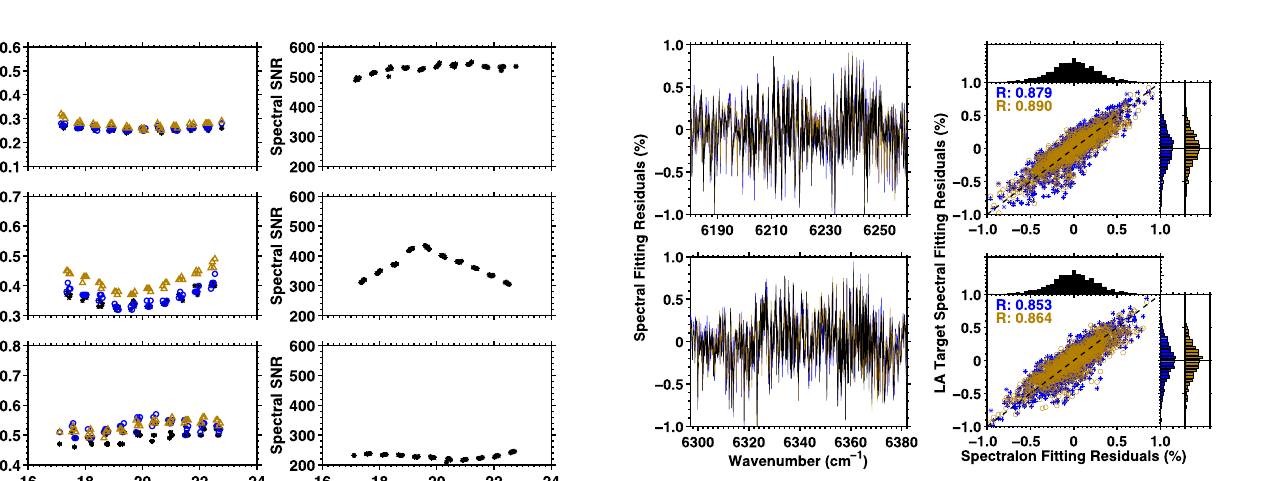
Figure 6 . The spectral fitting residuals (left panels) and their correlation, Pearson correlation coefficients (R), and histograms (right panels) with MW6220 (top panels) and MW6339 (bottom panels) for CO 2 slant column density measurements. In left panels, black curve is for Spectralon viewing geometry; blue curve is for west Pasadena; gold curve is for Arcadia Race Track. In right panels, blue stars are the correlation between Spectralon and west Pasadena; gold circles are the correlation between Spectralon and Arcadia Race Track; the black dash lines indicate the one to one correlation. The spectral fitting residuals were generated using the co-addition of residuals of 41 spectral fittings of Spectralon target, 41 spectral fittings of west Pasadena target, and 40 spectral fits of Arcadia Race Track target on January 3 rd , 2013. The systematic residuals arise from the imperfect line shape function and spectroscopic parameters in addition to uncertainties of atmospheric pressure and temperature parameters since the magnitude and positions of spiky fitting residuals consistently appear in all three target scenes. However, the magnitude of most of systematic fitting residuals is within 0.5% of spectral continuum levels.